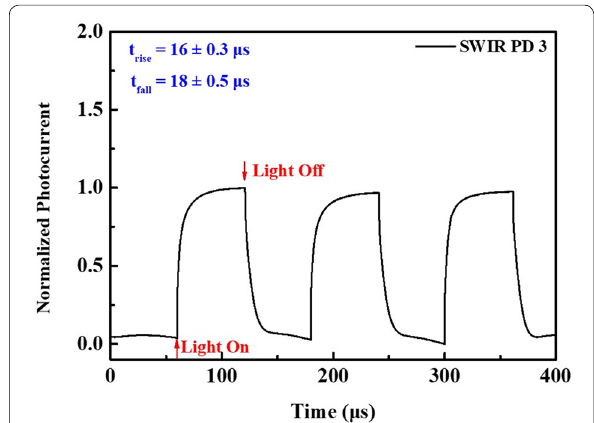
Fig. 7 Transient photo‑response waveform of PbS/CdS (thick shell) QD‑based SWIR photodetectors (SWIR PD3) with bias of